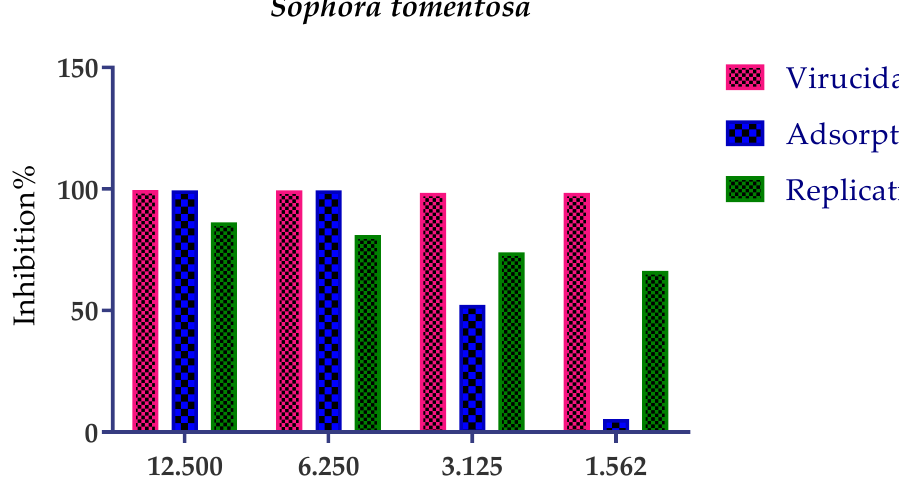
Figure 5. Mode of action for the most promising medicinal plant S. tomentosa (crude) with different safe concentrations against SARS-CoV-2 isolate ( h CoV-19/Egypt/NRC-3/2020). S. tomentosa had a promising effect (>99%) against SARS-CoV-2 by two mechanisms of action (virucidal and adsorption) with 12.50 and 6.25 µg/mL. On the other hand, its efficacy by adsorption decreased when decreasing the concentration but was still high (>99%) with a virucidal mechanism at 3.125 and 1.562 µg/mL. MERS-CoV by Crystal Violet Assay Both the 50% cytotoxic concentration (CC 50 ) and the 50% inhibitory concentration (IC 50 ) were measured in the same conditions for S. tomentosa (Figure 6).